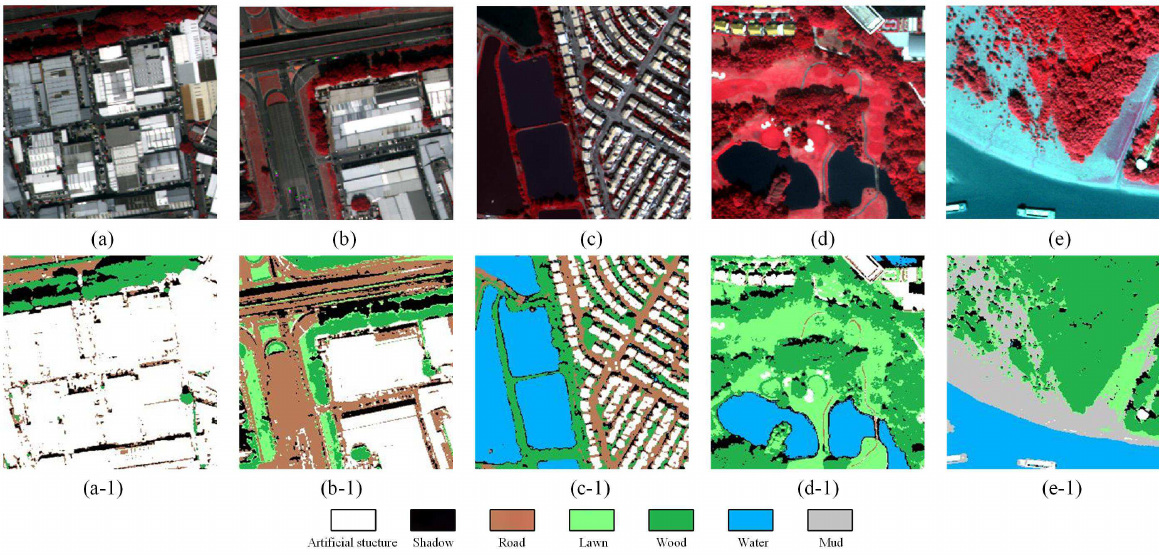
Figure 6. The results of experiments. (a)-(e) False color composite image. (a-1)-(e-1) The results of the proposed